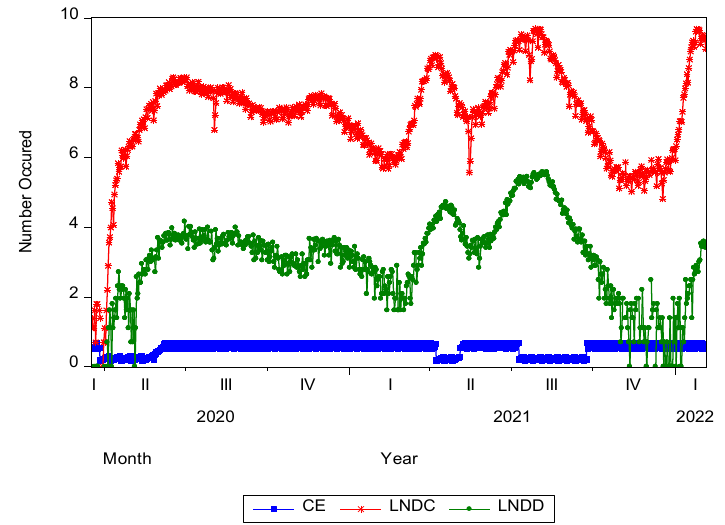
Fig. 1: Contributions of all the study variables